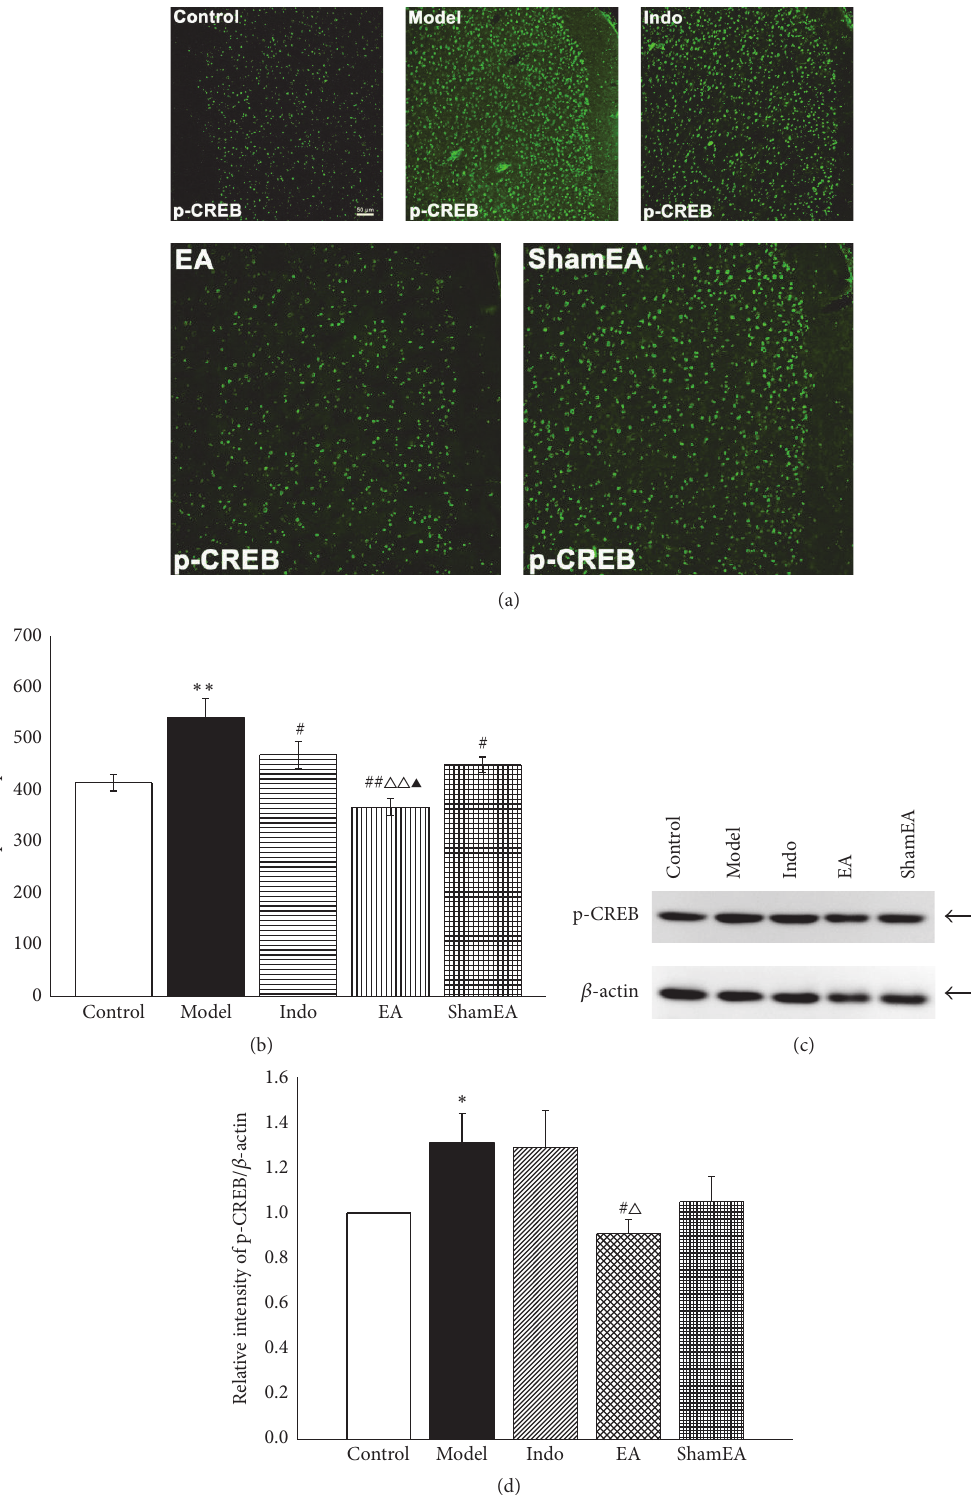
Figure 7: EA decreased CREB phosphorylation in the ACC of pain memory model rats. The right ACC tissues of different groups were prepared and labeled with immunofluorescence ( 𝑛 = 3 , five slides for each rat). Total protein extracts from the ACC tissues were detected by western blotting ( 𝑛 = 6 ). (a) Views of p-CREB-positive cells in the ACC (scale bar, 50 𝜇 m). (b) Quantification of p-CREB-positive cells showed that EA treatment at first injection time point significantly reduced the amount of positive p-CREB. (c) Western blotting analysis of p-CREB in the different groups. (d) Quantitative analysis using the western blot assay showed that EA significantly reduced phosphorylation level of CREB. Error bars indicated SEM. ∗ 𝑝 < 0.05 and ∗∗ 𝑝 < 0.01 , versus the control group; # 𝑝 < 0.05 and ## 𝑝 < 0.01 , versus the model group; △ 𝑝 < 0.05 and △△ 𝑝 < 0.01 , versus the indo group; 󳵳 𝑝 < 0.05 , versus the sham EA